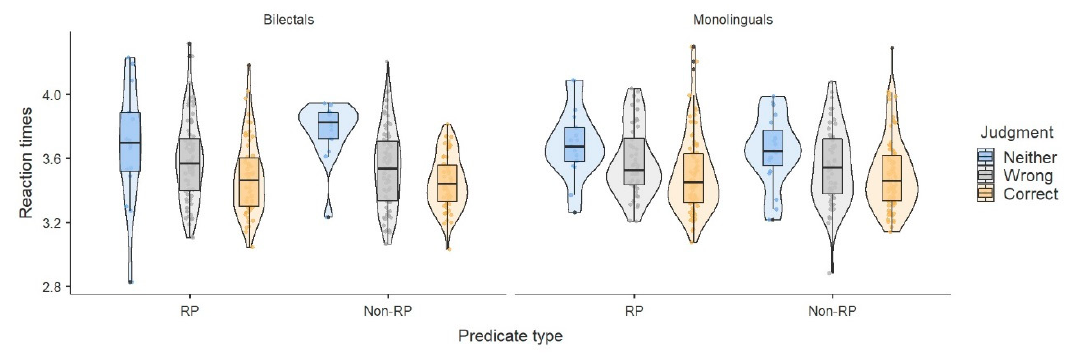
Figure 6. Log-transformed reaction times split for language group and type of predicate. RP = repeatable.